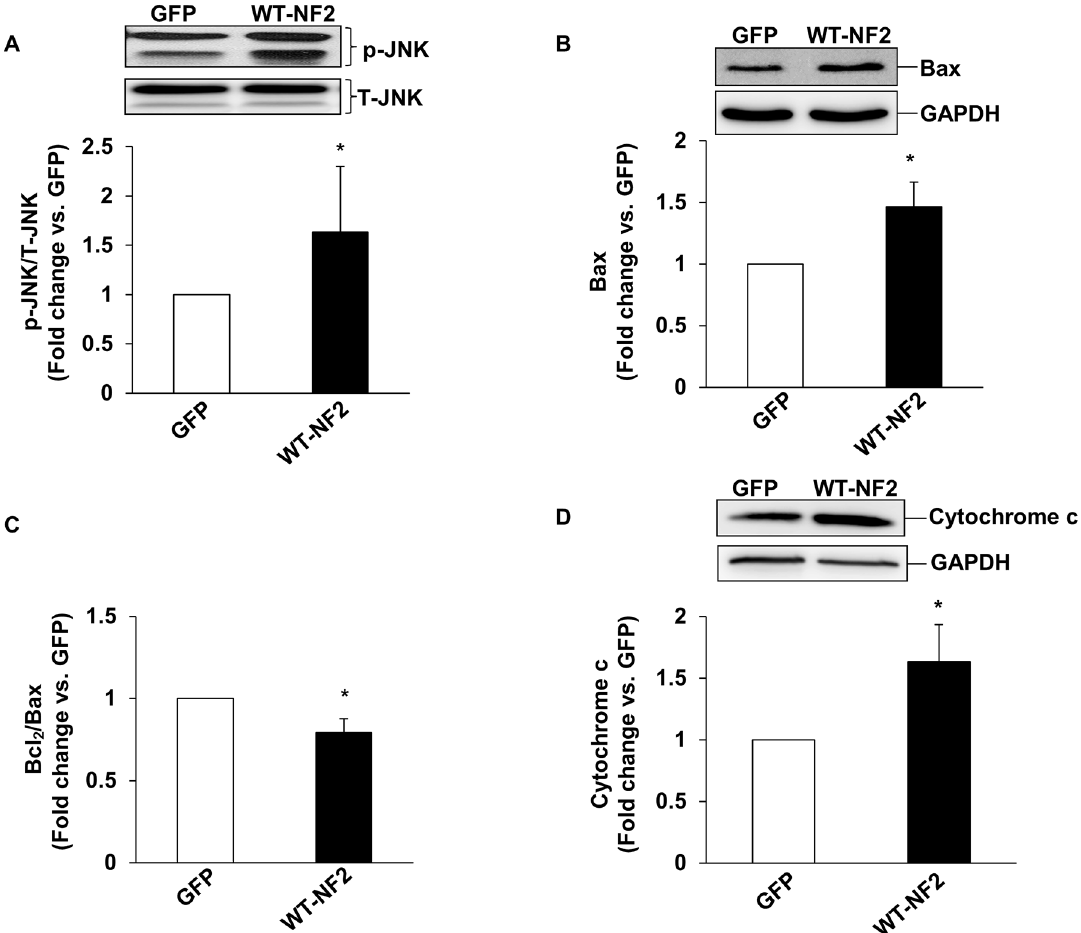
Fig 9. Adenoviral-mediated expression of NF2 activates mitochondrial death pathway in ARVMs. ARVMs were infected with adenoviruses expressing WT-NF2 or GFP for 48 h. Cell lysates were analyzed by western blots using phospho-specific anti-JNKs (A), anti-Bax (B), and anti-Bcl 2 antibodies (data not shown), while cytosolic fractions were analyzed by western blot using anti-cytochrome c (D) antibodies. The lower panels exhibit the mean data normalized to total JNKs (T-JNKs) or GAPDH. Fig 9 (C) represents Bcl 2 /Bax ratio. (cid:3) p < 0.05 vs GFP; n =